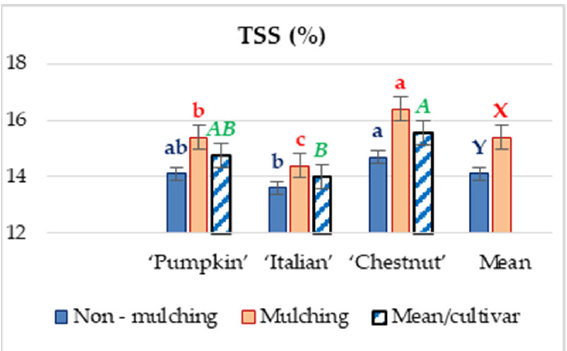
Figure 3. Total soluble substance of tuberous sweet potato roots (%). Bars represent standard error. Means followed by same letter are not significantly different (Tukey’s multiple range test, p < 0.05). The starch content varied between 13.7–14.6% in the non-mulched variants and be- tween 14.3–16.0% in the mulched versions (Figure 4). It was observed that the variation of this content depended on the cultivar, but the mulch also positively influenced the accumulation of starch.